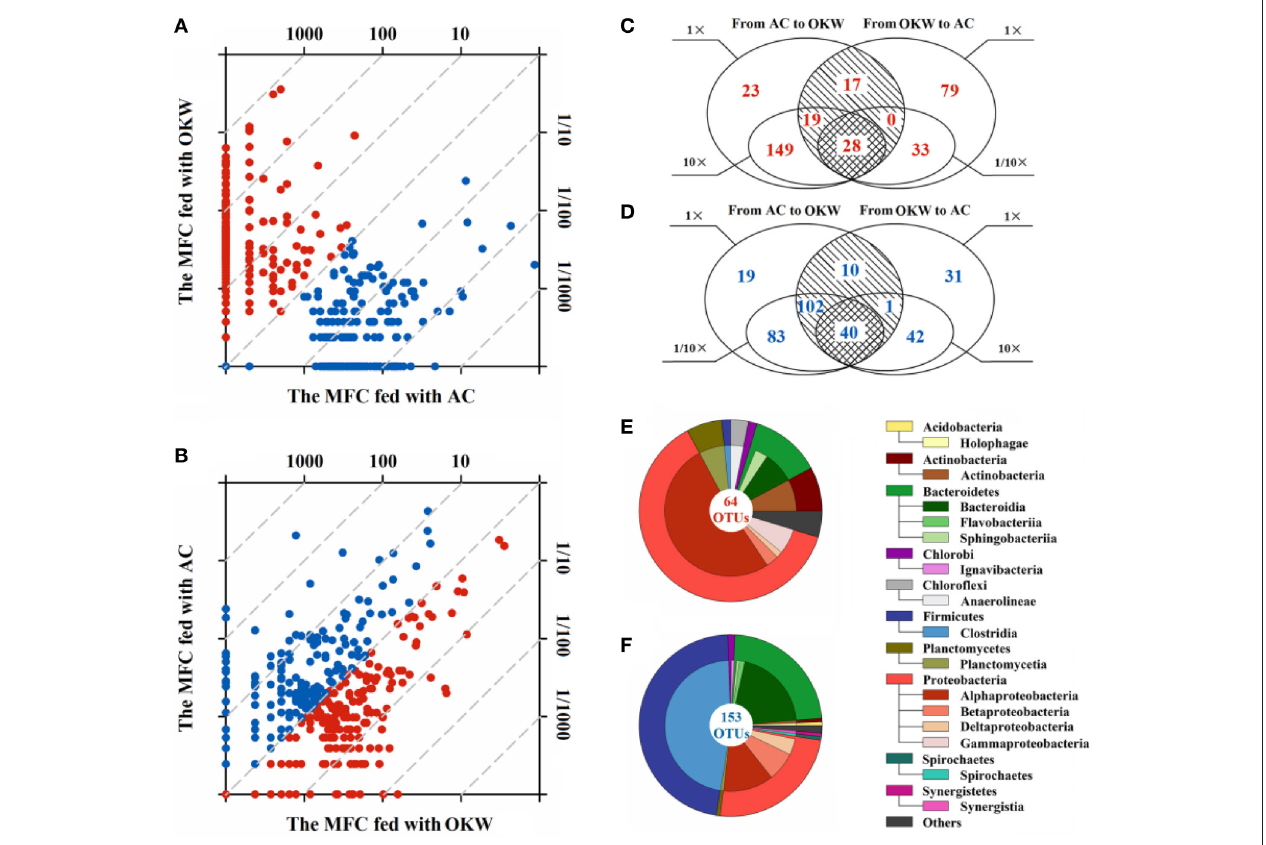
FIGURE 6 | Scatter plots of 500 dominant OTUs responses to the carbon source of MFCs. The carbon source of MFC changed from acetate to organic kitchen waste (A) and from organic kitchen waste to acetate (B) . (C,D) Detailed summary of OTUs that showed a significant response to changing carbon source. The 64 OTUs significantly adapted to acetate (E) and 153 OTUs significantly adapted to organic kitchen waste (F) were analyzed relative to taxonomic assignment. AC, acetate; OKW, organic kitchen